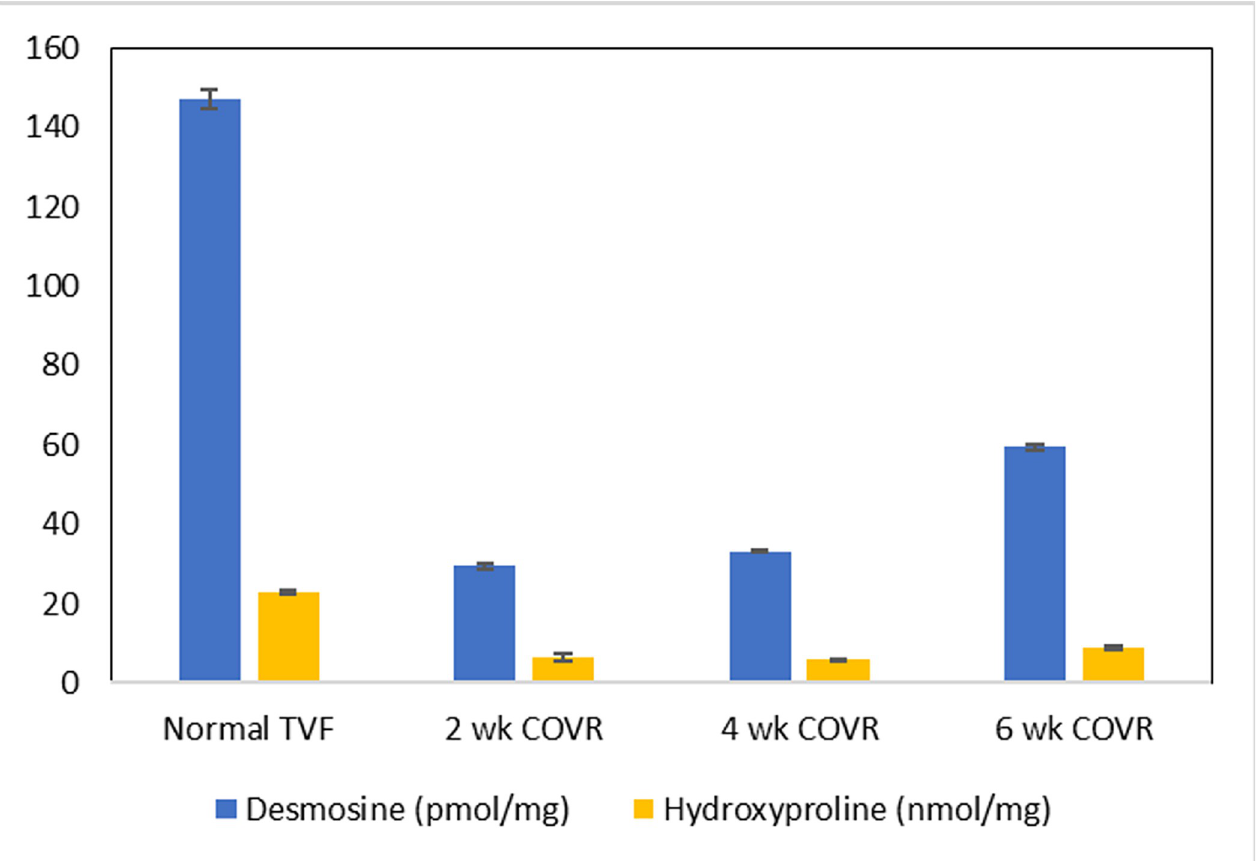
Fig 10. Amino acid quantitation. One porcine VF at each timepoint after COVR implant surgery was used for measurement of the amino acids desmosine/ isodesmosine and 4-hydroxyproline by LC–MS. Quantities were normalized to dry weight of tissue. Error bars show standard deviation between replicate